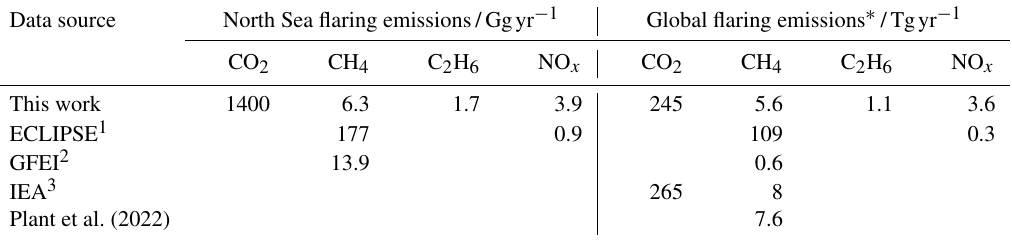
Figure 8. Correlation between measured (cid:49) NO x : (cid:49) CH 4 ratio and (a) combustion efficiency calculated with C 2 H 6 ( η C speed. Solid black lines show ordinary least squares linear regressions with p = 9 . 3 × 10 − 5 and 0.2, as well as R 2 = 0 . 24 and 0.03, for the relationship with combustion efficiency and wind speed respectively. Dashed black line shows the exponential relationship ( y = e x ) between (cid:49) NO x : (cid:49) CH 4 and combustion efficiency, for comparison. Table 2. Estimated total emissions of CO 2 , CH 4 , C 2 H 6 , and NO x from flared natural gas in the North Sea (in Gg) and globally (in Tg).